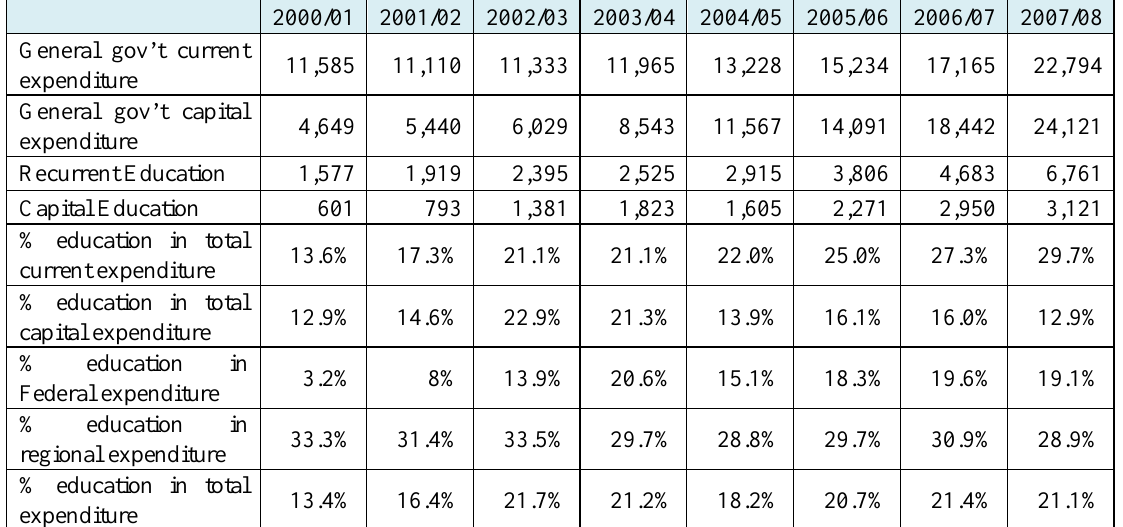
Table 5-3: Education Expenditure as Percentage of Government Expenditure (2000/01 - 2007/08) (million current